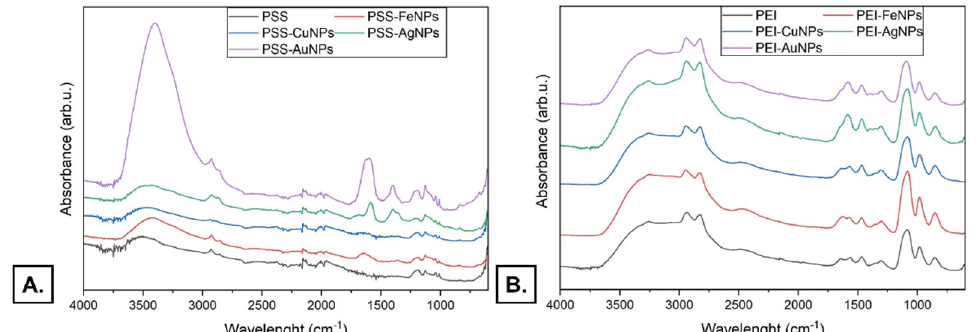
Figure 11. FTIR spectra of ( A ). polystyrene sulfonate and polystyrene sulfonate with AgNPs, AuNPs, CuNPs, FeNPs ( B ). polyethyleneimine and polyethyleneimine with AgNPs, AuNPs, CuNPs, FeNP. Key to the symbols: PSS—polystyrene sulfonate, PSS-AuNPs- polystyrene sulfonate with AuNPs, PSS-AgNPs- polystyrene sulfonate with AgNPs, PSS-CuNPs- polystyrene sulfonate with CuNPs; PSS-FeNPs- polystyrene sulfonate with FeNPs; PEI—polyethyleneimine, PEI-AuNPs polyethyleneimine with AuNPs, PEI-AgNPs polyethyleneimine with AgNPs, PEI-CuNPs polyethyleneimine with CuNPs, PEI-FeNPs polyethyleneimine with FeNPs.